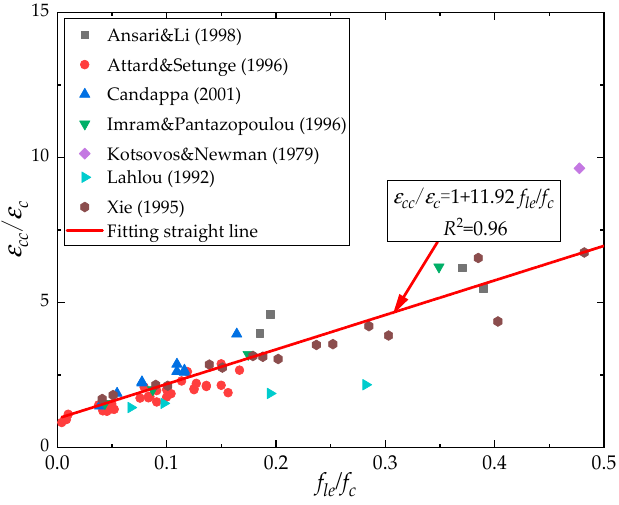
Figure 4. Relationship between 𝜀 (cid:3030)(cid:3030) /𝜀 (cid:3030) and 𝑓 (cid:3039)(cid:3032) /𝑓 (cid:3030) . [24–26,28–31,33].